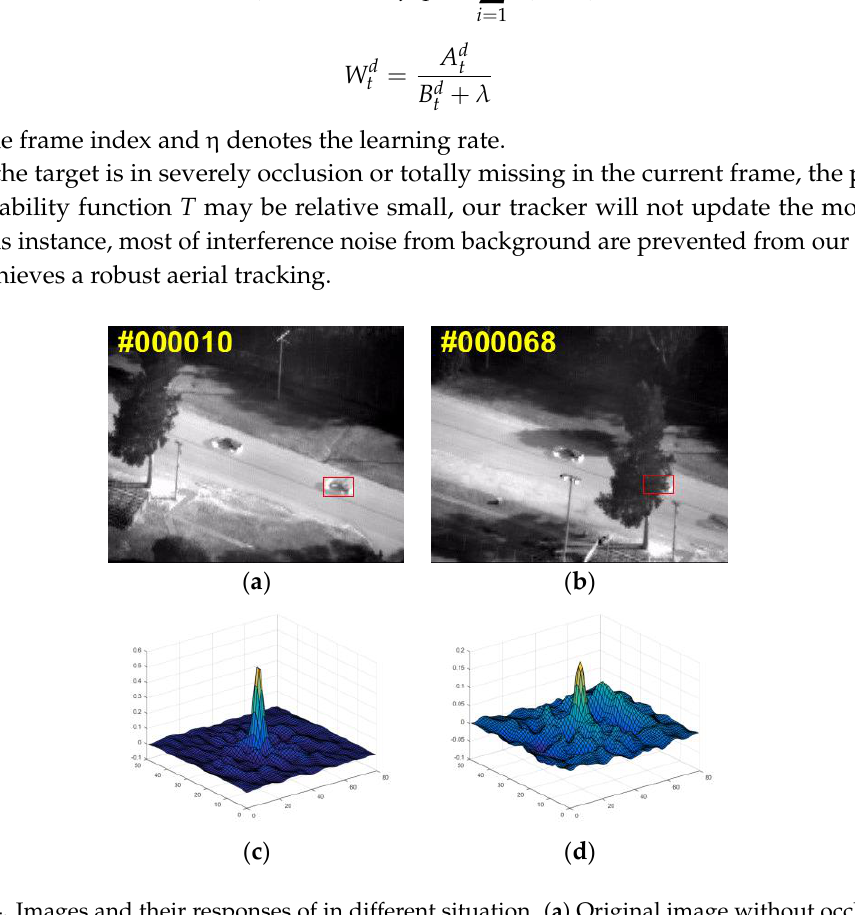
Figure 4. Images and their responses of in different situation. ( a ) Original image without occlusion; ( b ) Original image with serious occlusion; ( c ) Response map of ( a ); ( d ) Response map of ( b